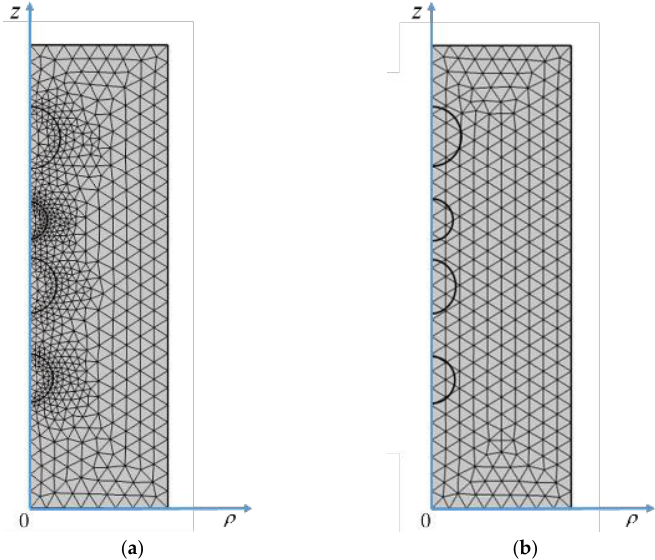
( b ) Figure 10. Electric potential distribution of bubbles in liquid nitrogen. ( a ) CFEM, ( b ) XFEM